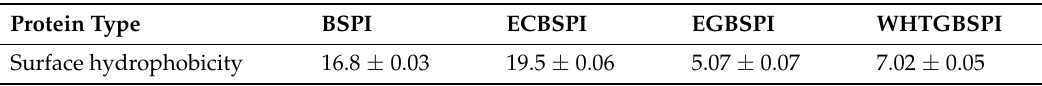
Table 2. Surface hydrophobicity evaluated results of BSPI and its modified products. Protein Type